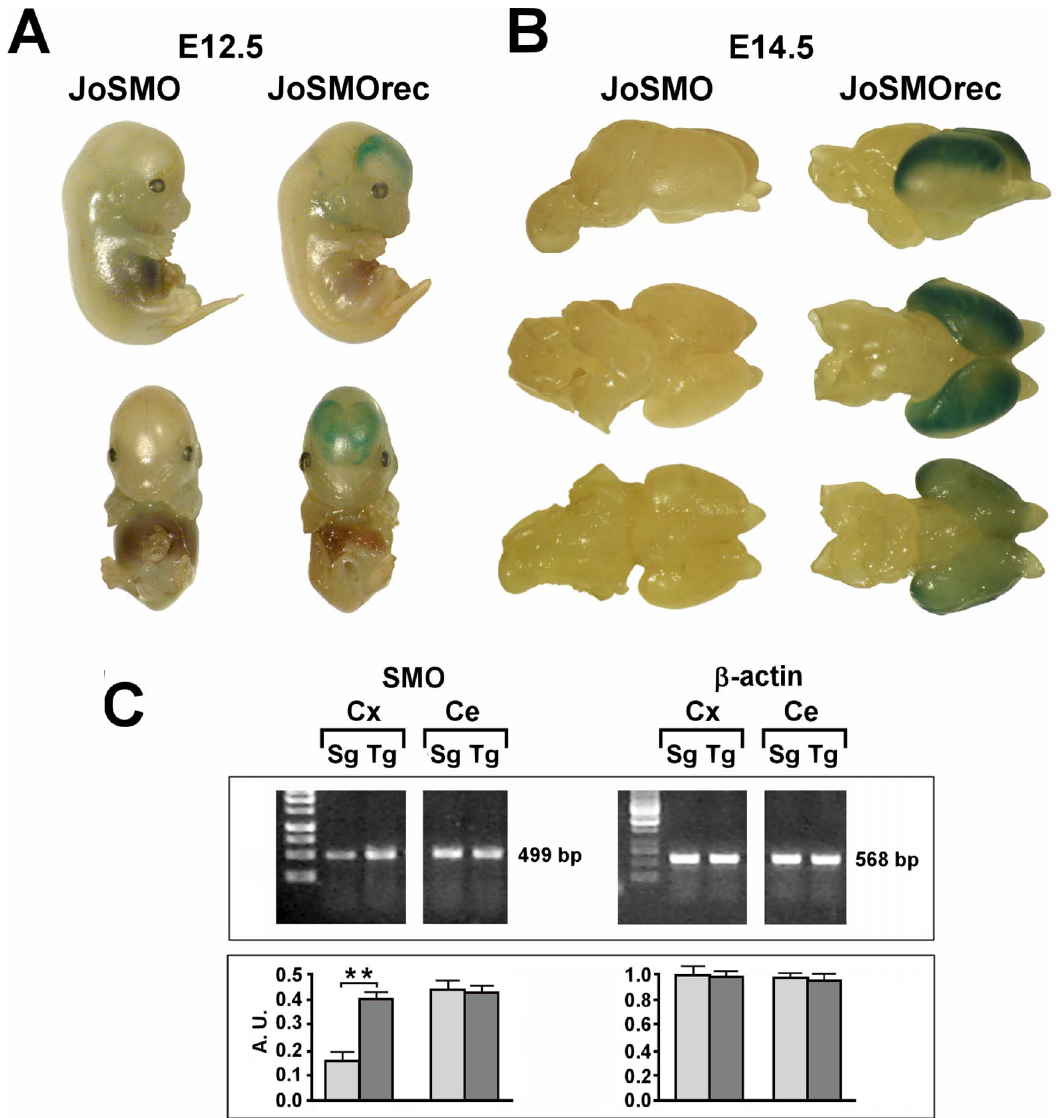
Figure 2. Functional analysis of the second reporter gene LacZ of whole-mount and isolated brains. A . LacZ staining of whole-mount at E12.5 mouse developmental stage. B . LacZ staining of brain from JoSMOrec mice at E14.5 developmental stage. C . SMO transcript level analyses by semiquantitative RT-PCR in the neocortex of JoSMOrec mice and densitometric. Representative RT-PCR experiments from three independent replicas are shown. Densitometric analyses of PCR gel bands, represent the measurements done on three separate experiments. The b -actin gene expression was used for normalization. An arbitrary densitometric unit bar graph (A.U.) is shown. The p values were measured with the one-way ANOVA test and post-hoc test Bonferroni (**, p , 0.01). Sg, syngenic mice; Tg, transgenic mice; Cx, cortex; Ce,